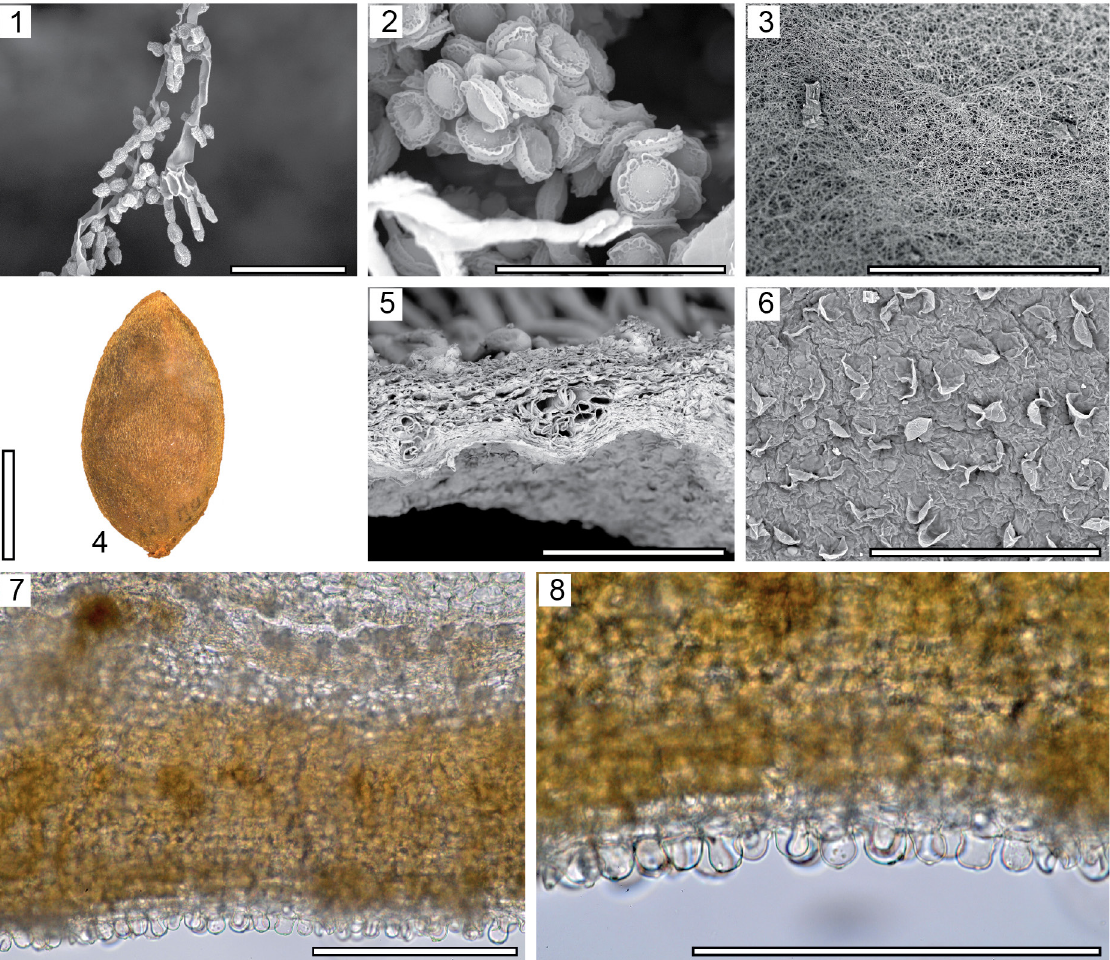
Fig. 38. Preservation issues. 1 . Fungal mycelium and echinate spore from Vadensea vogelii (Miers) Jongkind & O.Lachenaud ( Service forestier 364 ). 2 . Fungal rounded spore from Pyrenacantha glabrescens (Engl.) Engl. ( A. Chevalier 17326 ). 3 . Dense mycelium on the locule lining of Natsiatum herpeticum Buch.-Ham. ex Arn. ( H.B. Cale s.n. ). – 4 – 6 . Iodes vitiginea (Hance) Hance ( J.F. Maxwell 92-328 ) 4 . Fruit, lateral view. 5 . SEM image of the undifferentiated pericarp in transverse section 6 .